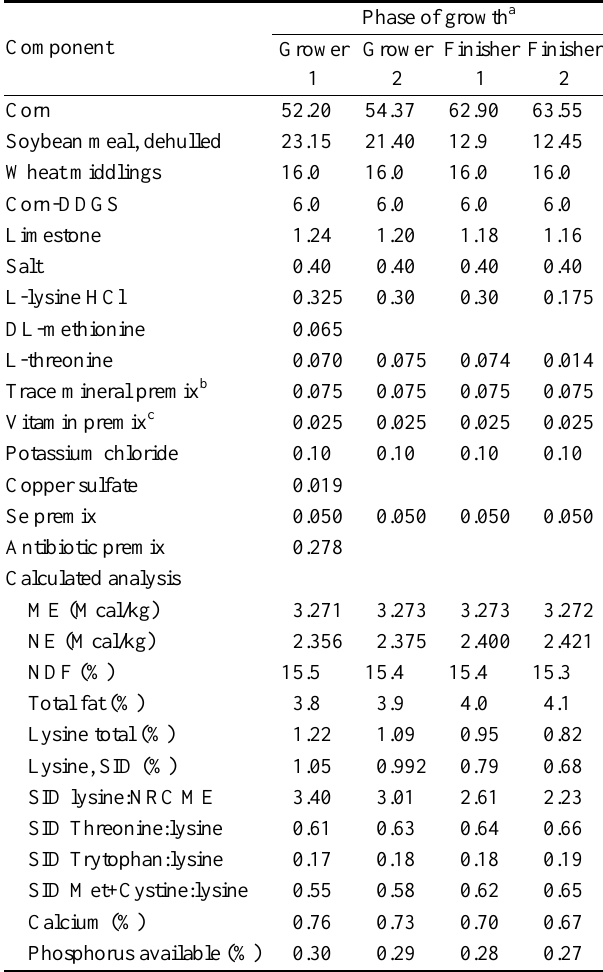
Table 1. Diet composition (%) specifications for the low